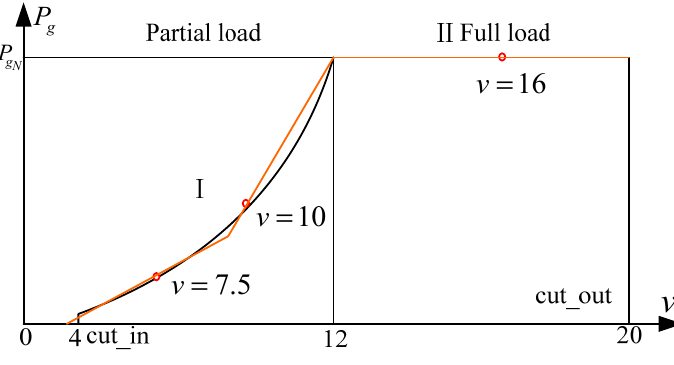
Figure 4. Wind speed vs. the corresponding working